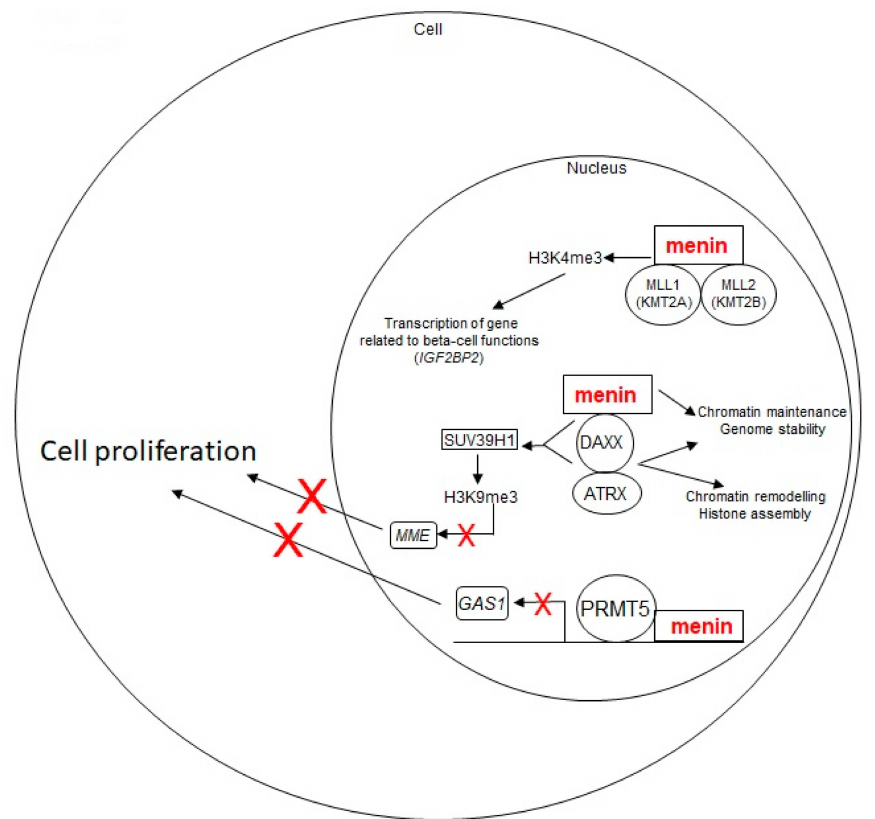
Figure 2. Schematic representation of menin-regulated pathways with a potential role in pNET tumorigenesis. Wild-type menin acts as a tumor suppressor for pNET development. It plays a role in chromatin remodeling and genomic stability and, via its direct interaction with the MLL1/MLL2 and DAXX-ATRX complexes, in histone methylation-driven gene transcription, and negatively regulates cell proliferation. Loss of wild-type menin results in an uncontrolled cell growth, leading to tumor development. The red X marks indicate the inhibition of a biological process (i.e., gene transcription, cell